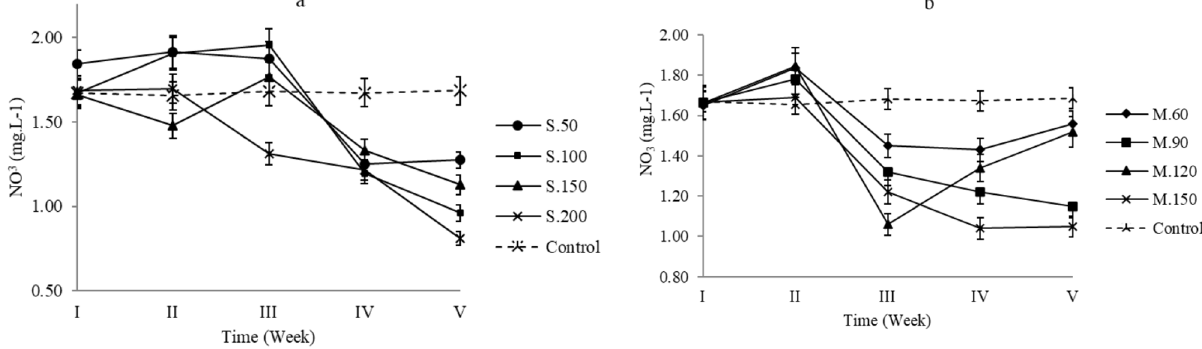
Fig. 8. Concentration dynamics of NO 3 (mgL (cid:1) 1 ) in the control and at various densities of G. verucosa (a) and P. viridis (b).